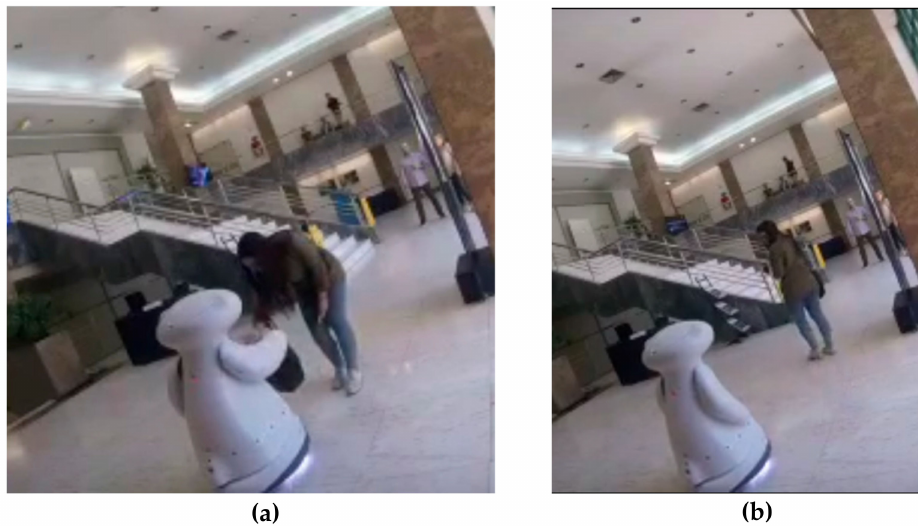
Figure 2. Exploring the skills of the robot. ( a ) Person taking the initiative of starting an interaction with the robot; ( b ) Person looking back to confirm that the robot is not going to continue interacting.